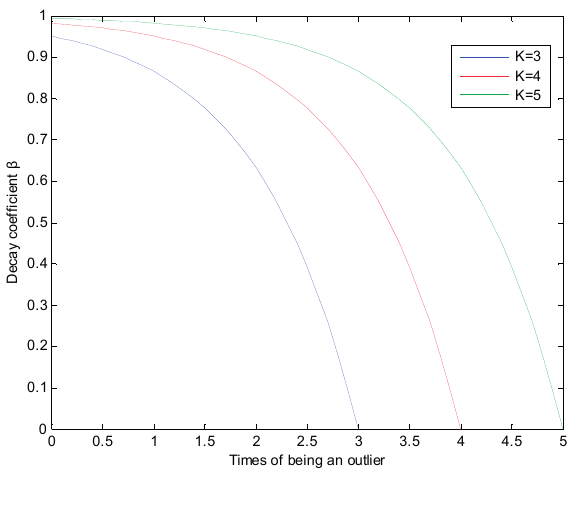
Figure 7. Decay function β .